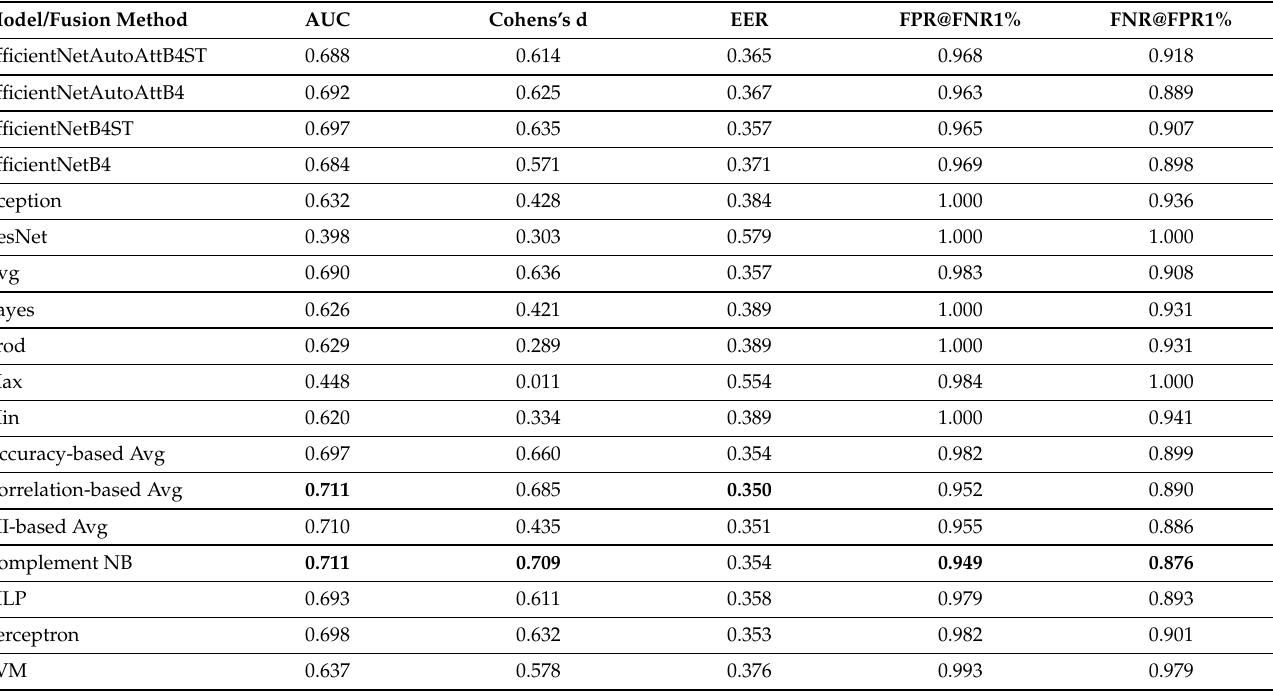
Table 3. The results on the DFDC in the cross-dataset scenario (the best values related to each performance metric are reported in